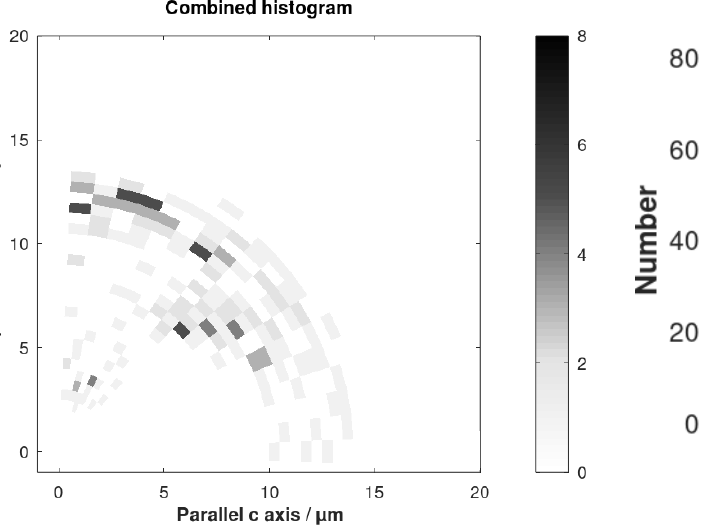
Figure E3. The corrected histogram as a result of the inversion of the 3D histogram shown in Fig. E1.